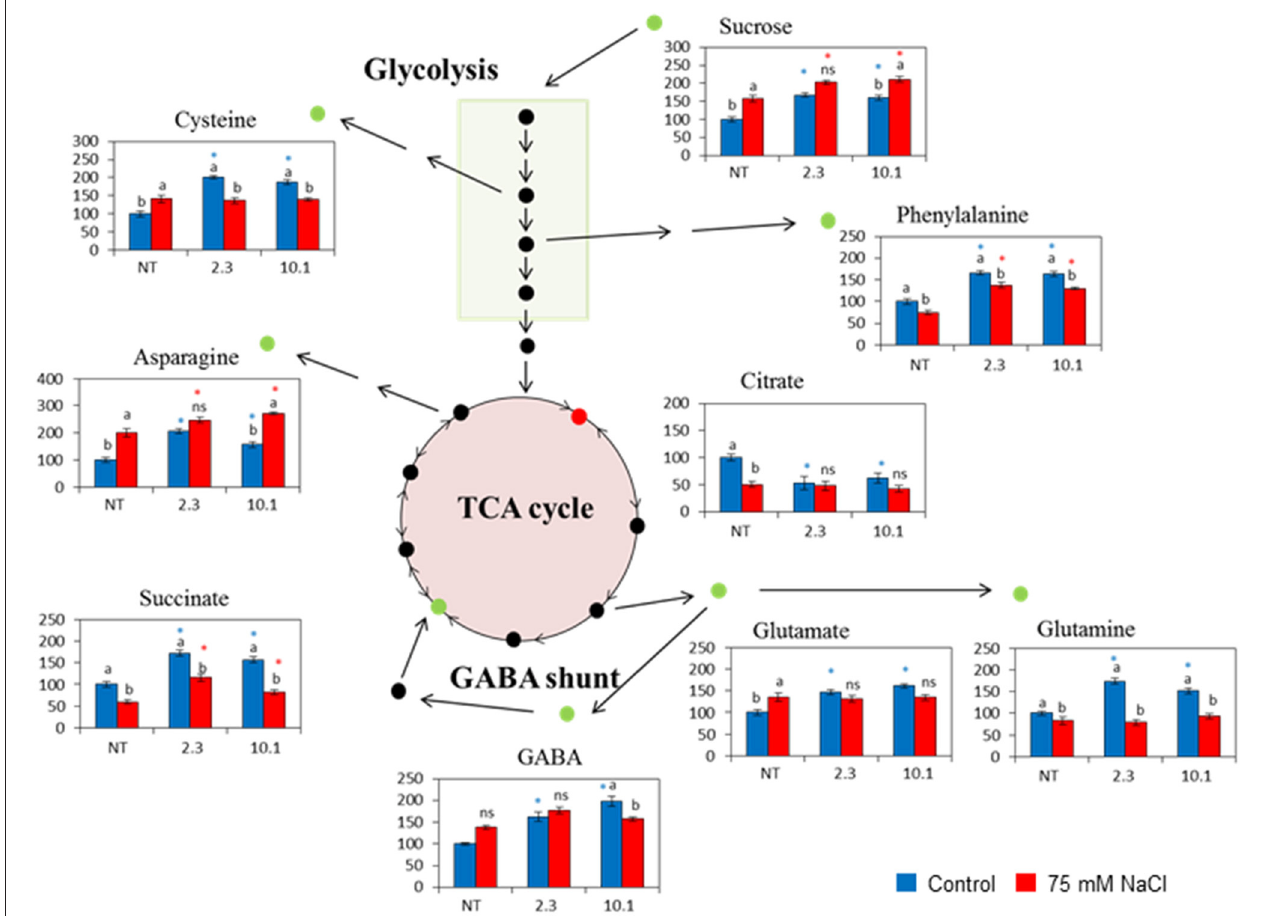
FIGURE 4 | Schematic representation of the altered metabolism in the 35S::AtCDF3 plants (lines 2.3 and 10.1) under the control (blue bars) and salinity (red bars) conditions. Thirty-day-old NT and 35S::AICDF3 plants (L 2.3 and 10.1) were grown in hydroponic culture under control and salinity (75 mM NaCl) conditions. Metabolomic determinations in leaves were performed after 15 days. The relative quantities (% of NT) of the selected metabolites analyzed by gas chromatography-selected ion monitoring-mass spectrometry are displayed. Different letters indicate the significant differences ( P < 0.05) within each genotype for the stress effect. Differences between genotypes per treatment are indicated by an asterisk. NT,